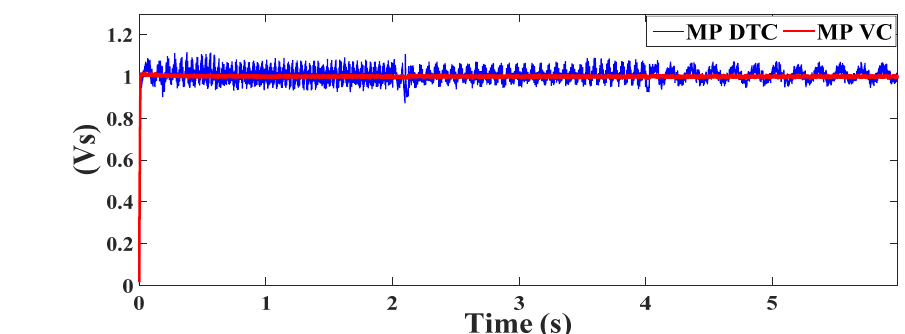
Figure 26. Stator flux profiles for the two control algorithms (Vs).